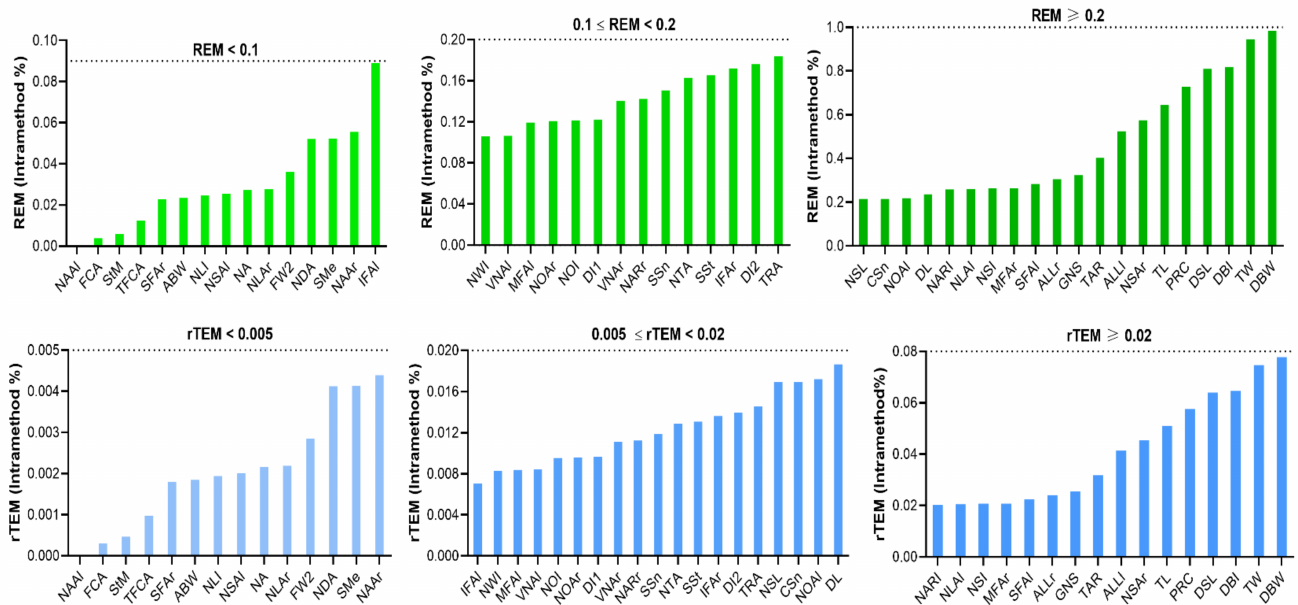
Figure 10. Intra-method relative error measurement (REM) and relative technical error of measure- ment (rTEM) of novel nasal measurements on three-dimensional